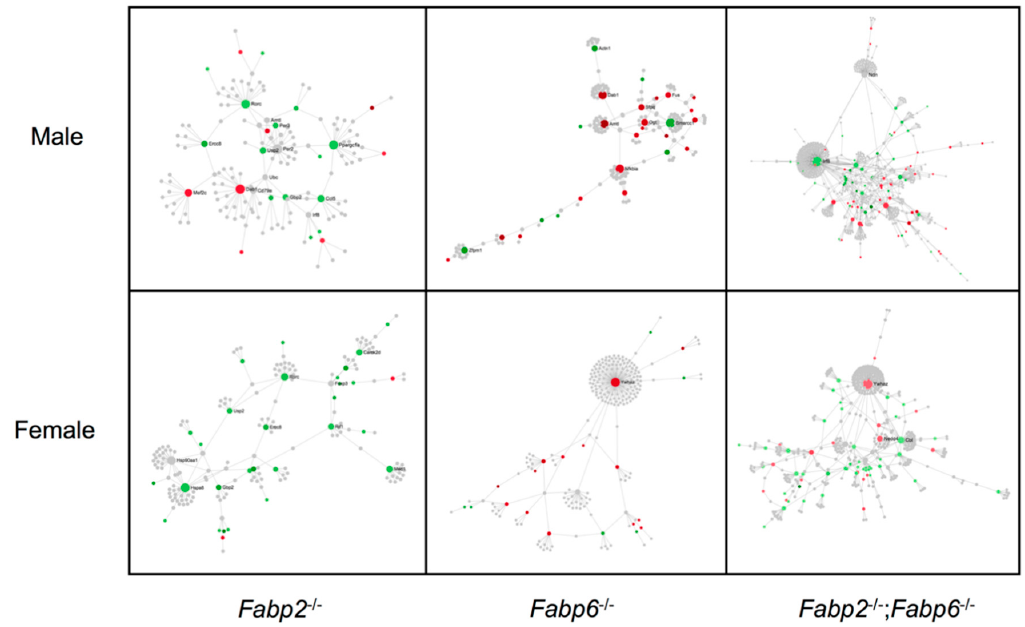
Figure 4. The protein–protein interaction networks of DE genes in different Fabp gene-disrupted genotypes ( Fabp2 – / – , Fabp6 – / – , and Fabp2 – / – ; Fabp6 – / – ). Three types of proteins (nodes) are presented in